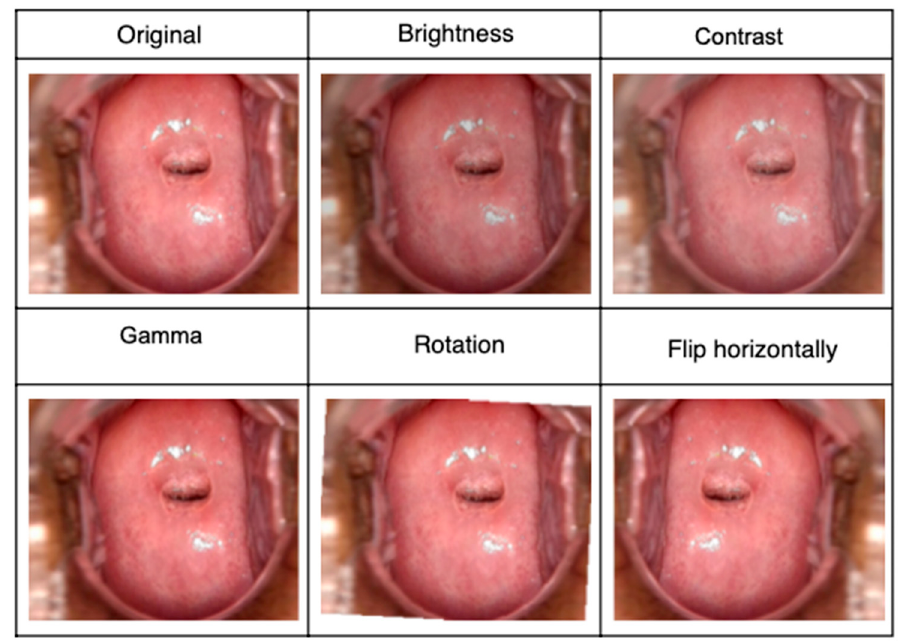
Figure 2. Some original images and the geometric transformations which were used in the data augmentation.